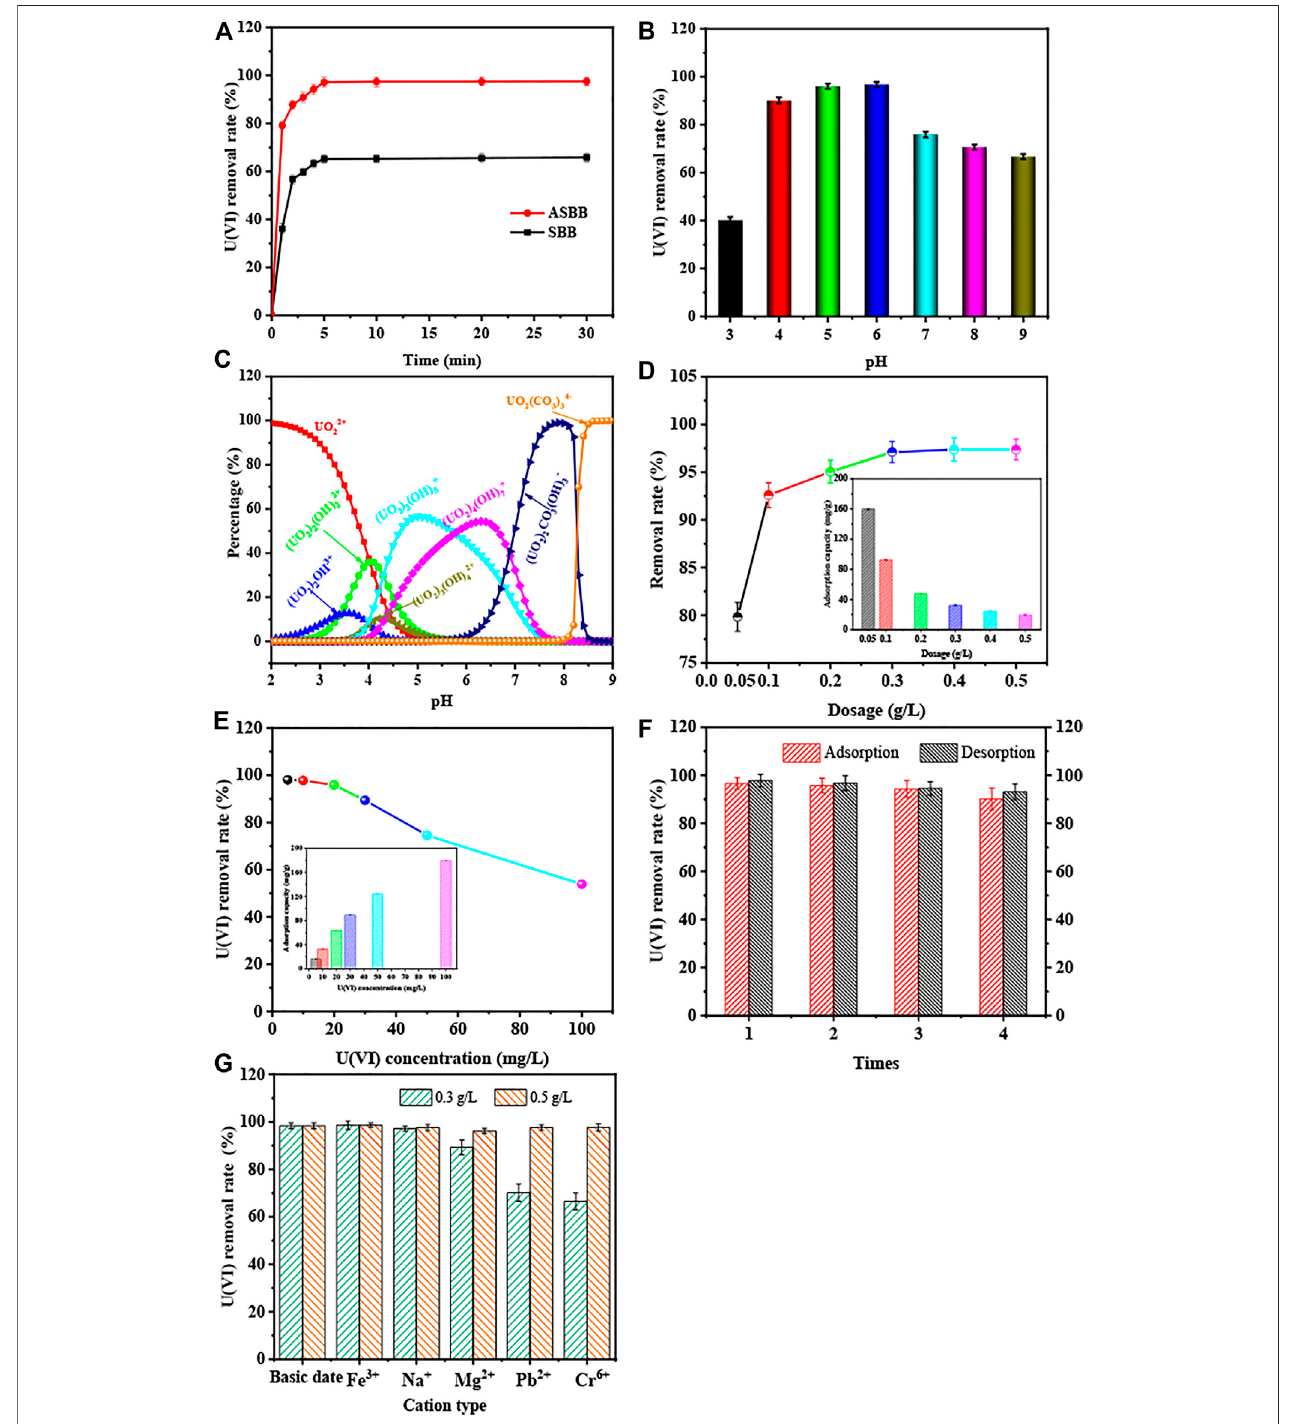
FIGURE3| SorptionrateofU(VI)bySBBorASBBunderdifferentconditions. (A) ReactiontimeofSBBorASBBforU(VI)sorption, (B) U(VI)sorptionbyASBBunder difference initial pH of USW, (C) simulation calculation of the existing state of uranium ions under different pH conditions, (D) removal rate of uranium in USW by ASBB under different dosage, (E) the removal rate of uranium ions by ASBB at different initial concentrations of USW, (F) desorption ef fi ciency of uranium ions by ASBB, (G) effect of interfering ions on sorption of uranium ions by ASBB in USW.